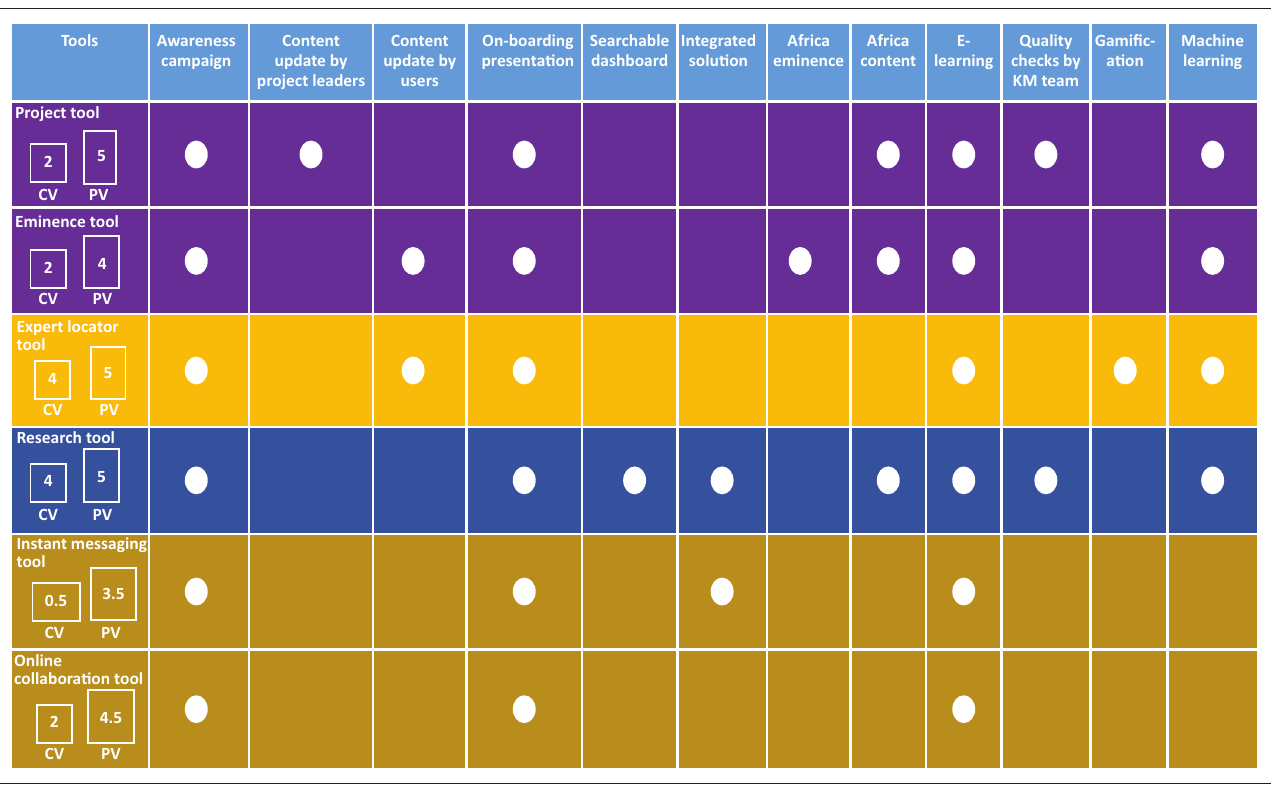
FIGURE 3: Recommendations for knowledge management toolkit